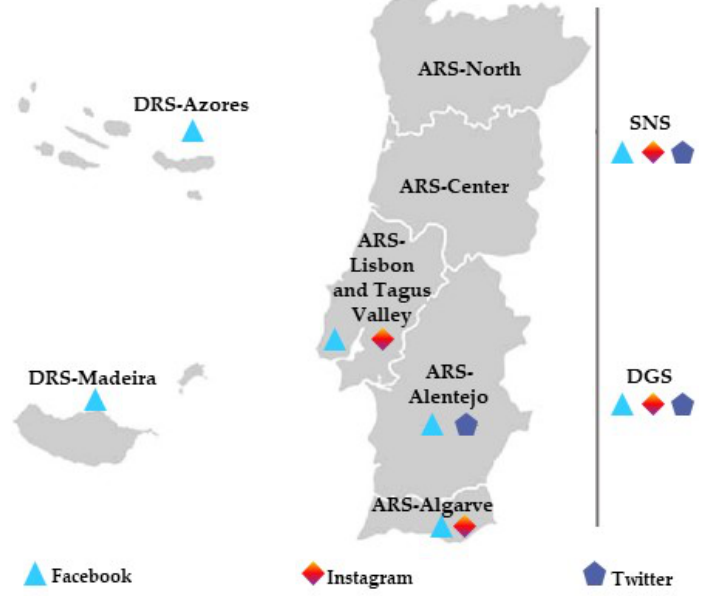
Figure 1. Presence of Portuguese health entities on social media.